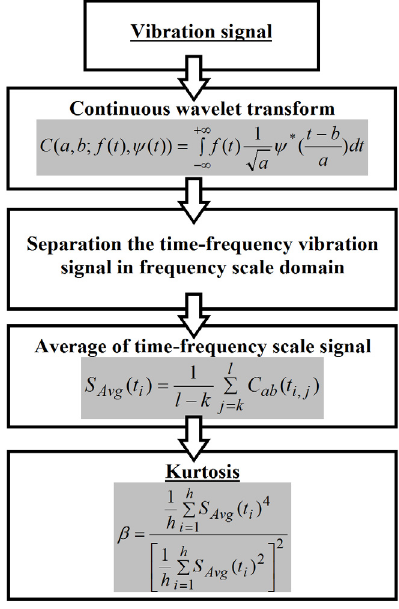
Figure 14. Algorithm of the performed calculations for the determination of kurtosis (details in [66]).